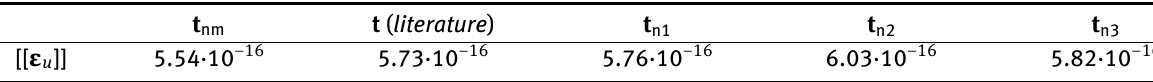
Figure 4: Eigenvalues of the Force Density matrices of the Quadruplex Table 2: Norm of the unbalanced residual normalized internal forces vectors of the Quadruplex